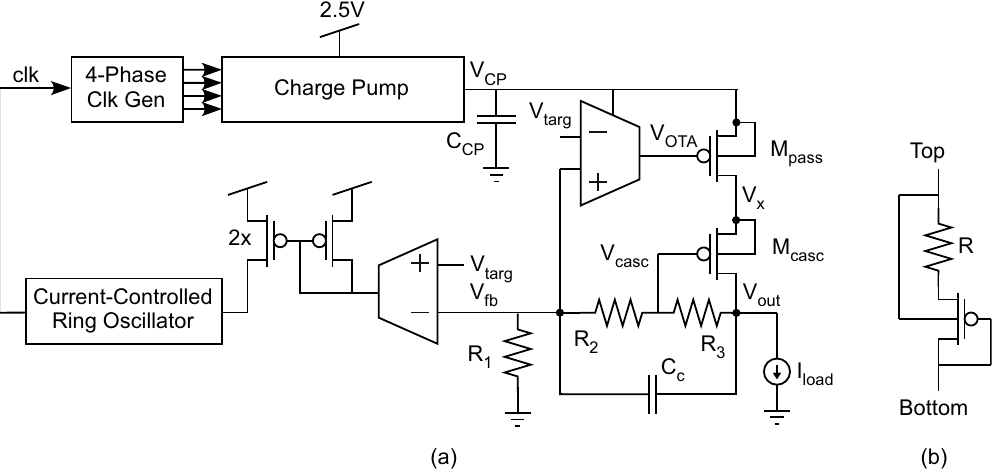
Figure 4. ( a ) Circuit diagram of the proposed injection charge pump with a low-drop-out regulator (LDO) in the loop. ( b ) Resistor divider